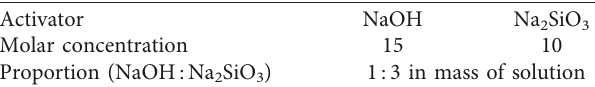
Table 2: Molar concentration and proportions of the activating